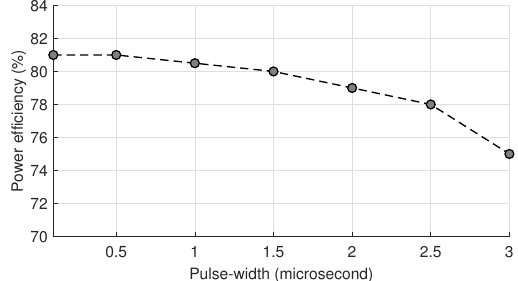
Figure 9. Power efficiency function of